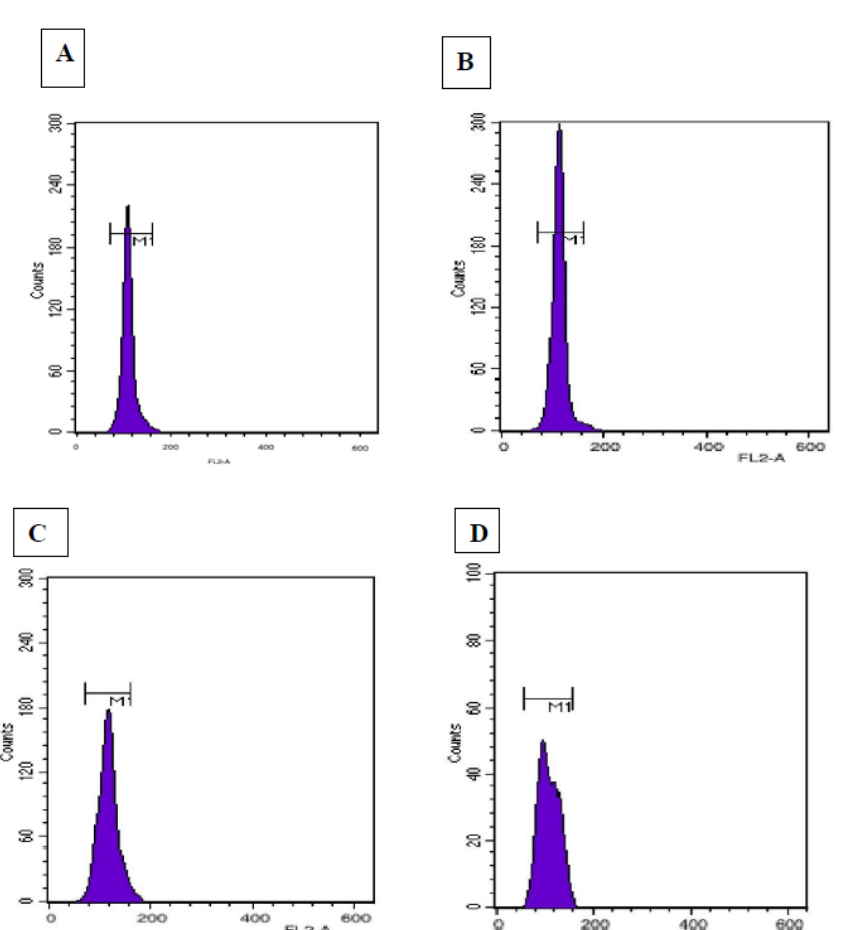
Figure 8. Flow cytometric histogram peaks of relative 2C DNA content of nuclei obtained from ( A ) Digitalis lanata (standard), ( B ) Field-grown (mother) plant, ( C ) somatic embryo regenerated plant, and ( D ) organogenic-derived plant of Digitalis purpurea .